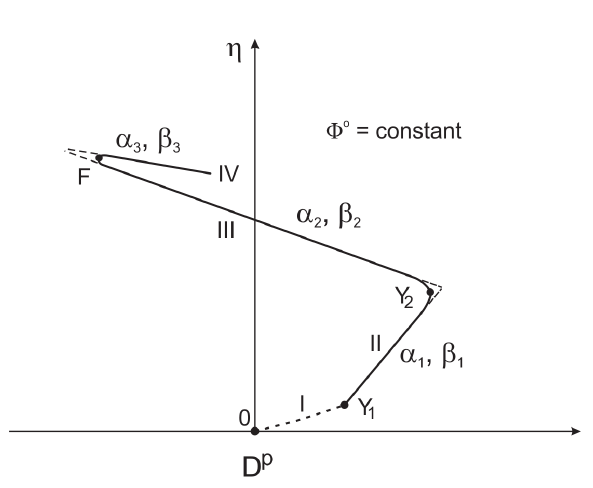
Figure 1: Scheme of stress ratio–plastic dilatancy